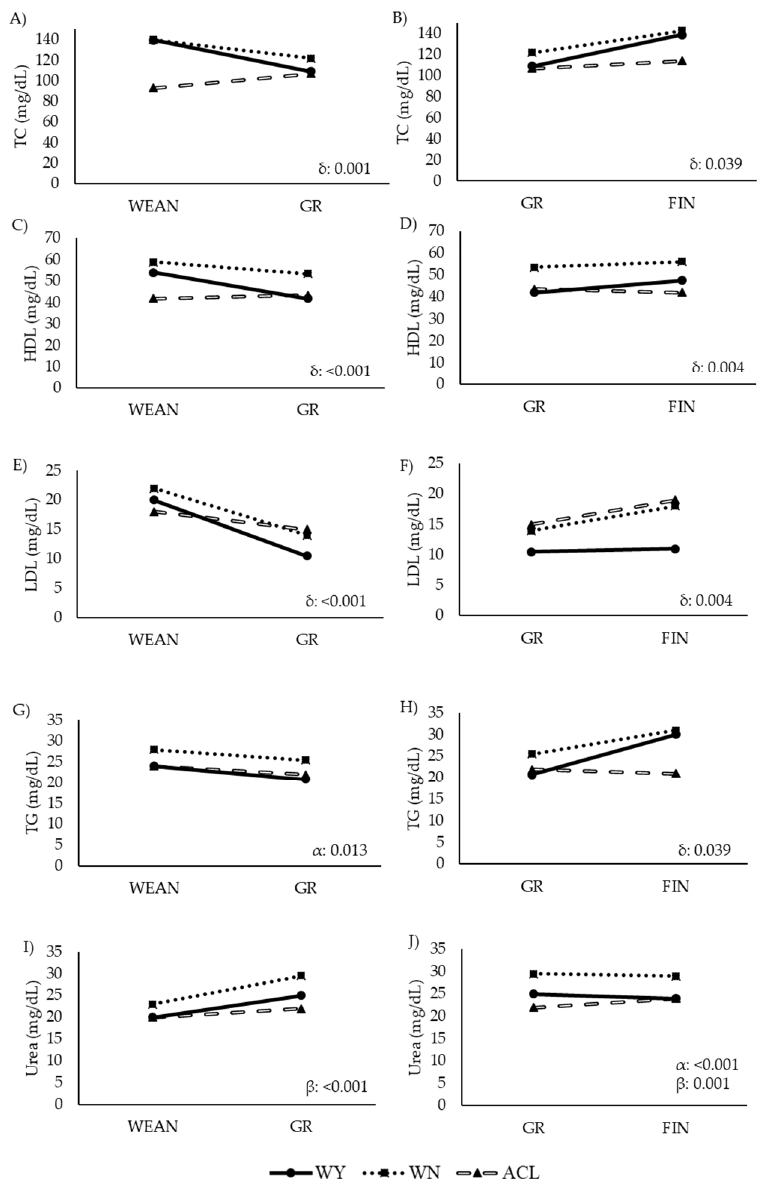
Figure 7. Comparison of levels of lipid-related metabolites and urea in steers at two time points during the fattening period (longitudinal approach). Abbreviations: ACL: crossbred animals Angus-by-Charolais or Angus-by-Limousin; GR to FIN: growing to finishing interval; HDL: high density lipoprotein cholesterol: Panels ( C,D ); l; LDL: low density lipoprotein cholesterol: Panels ( E,F ); TC: Serum total cholesterol: Panels ( A,B ); TG (mg/dL): triglycerides: Panels ( G,H ); Urea (mg/dL): Panels ( I,J ); WEAN to GR: weaning to growing interval; WN: Wangus animals (Wagyu-by-Angus); WY: fullblood Wagyu. Parameters are expressed with median values. α indicates significant effect of breed; β indicates significant effect of time; δ indicates significant effect of the interaction between breed and time.